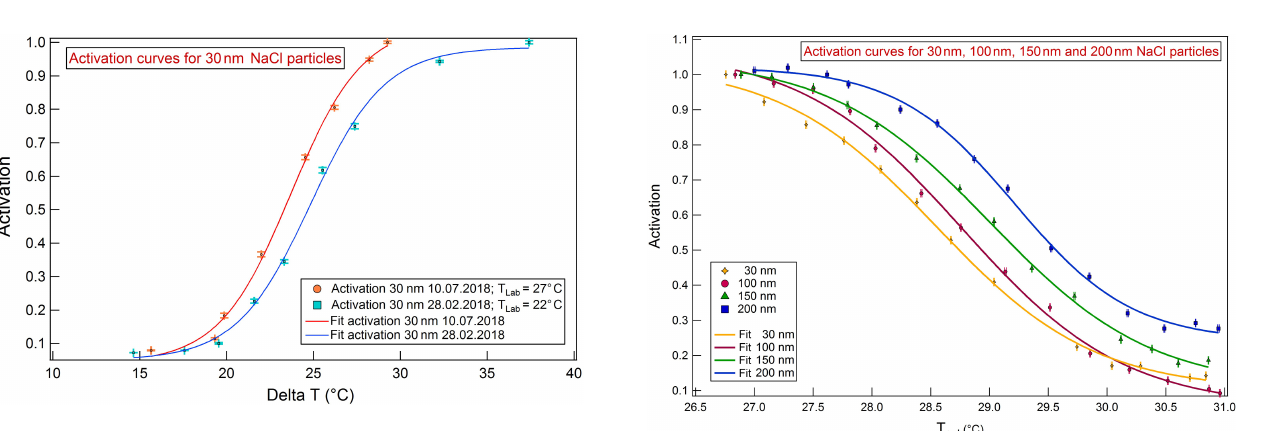
Figure 5. Activation curves for NaCl particles with 30nm size mea- sured in winter (blue curve, laboratory temperature 22 ◦ C) and sum- mer (red curve, laboratory temperature 27 ◦ C).